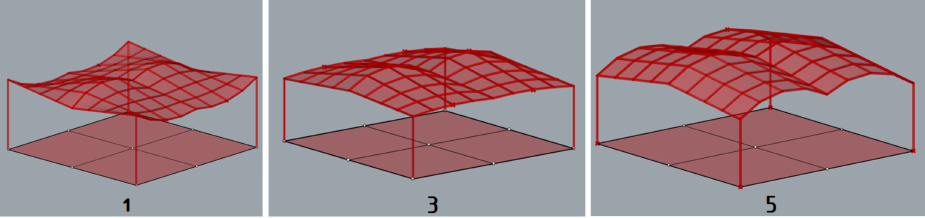
Figure 7. The models of the roof structures composed of cylindroid units favorable in terms of shape.